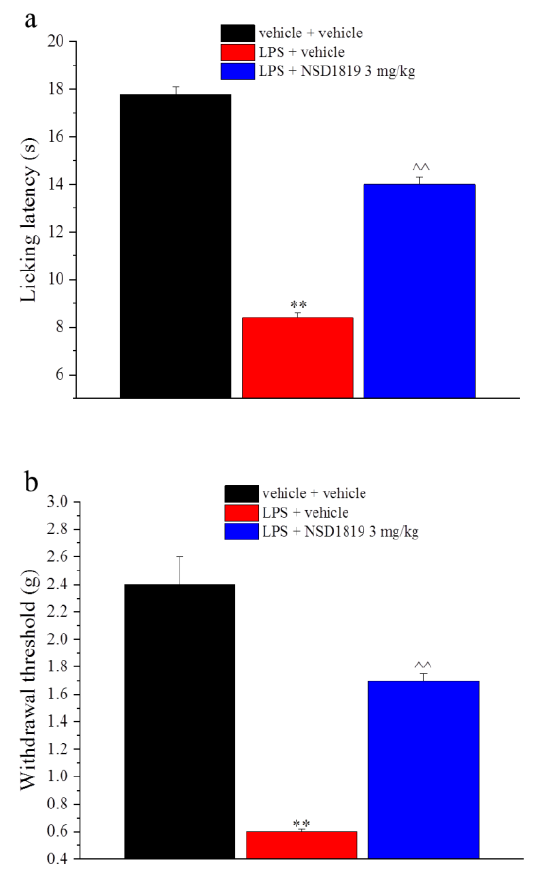
Figure 2. Effect of NSD1819 on LPS-induced thermal and mechanical allodynia. LPS (1 mg/kg) was intraperitoneally injected for five consecutive days (from 1 to 5). NSD1819 was suspended in 1% carboxymethylcellulose sodium salt (CMC) and daily orally administered starting from day 1 until the end of the experiment. Control animals were treated with vehicles. On day 8, 16 h after the last administration of the compound, ( a ) thermal and ( b ) mechanical allodynia were assessed by the Cold plate and von Frey tests, respectively. Data are expressed as the mean ± S.E.M. of values from 8 mice analyzed in 2 different experimental sets. ** p < 0.01 vs. vehicle + vehicle; ˆˆ p < 0.01 vs. LPS +